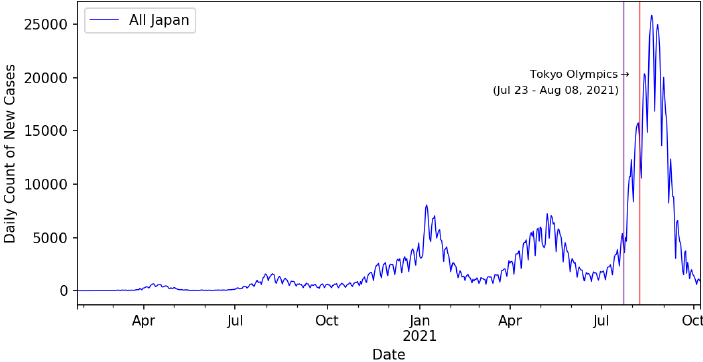
Figure 8. Daily count of new cases in all Japan for data until 8 October 2021.